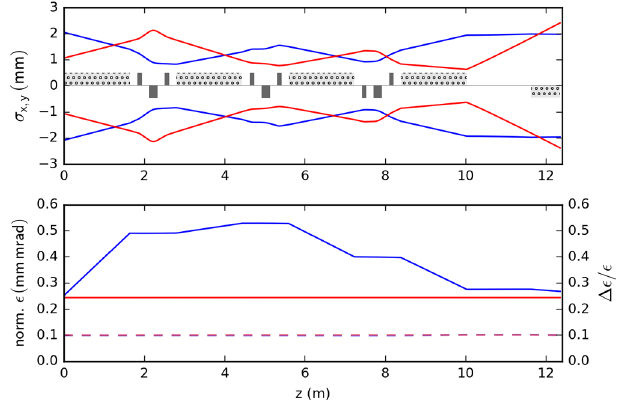
FIG. 13. rms beam envelope through the second arc with waterbag initial distribution and 20 mA bunch current. The downward circle patterned box represent the bending magnet of negative bending angle.